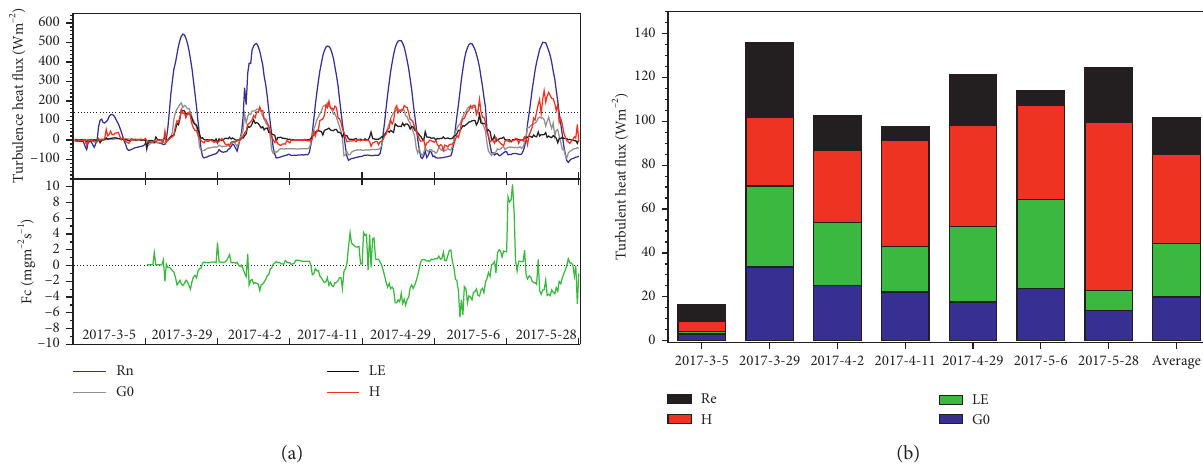
Figure 7: Changes in the surface energy balance of different underlying surface periods. (a) Changes in the components of the surface energy budget. (b) The proportion of the surface energy budget components in the net